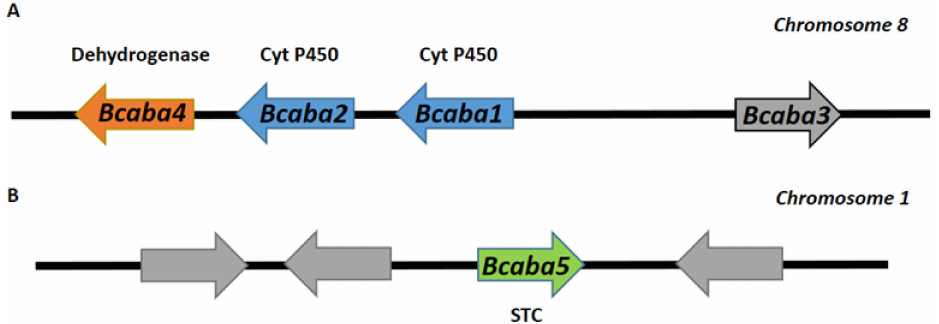
Figure 3. ( A ) The ABA gene cluster ( B ) the Bcsct5/Bcaba5 gene locus in the genomes of B. cinerea strain B05.10.